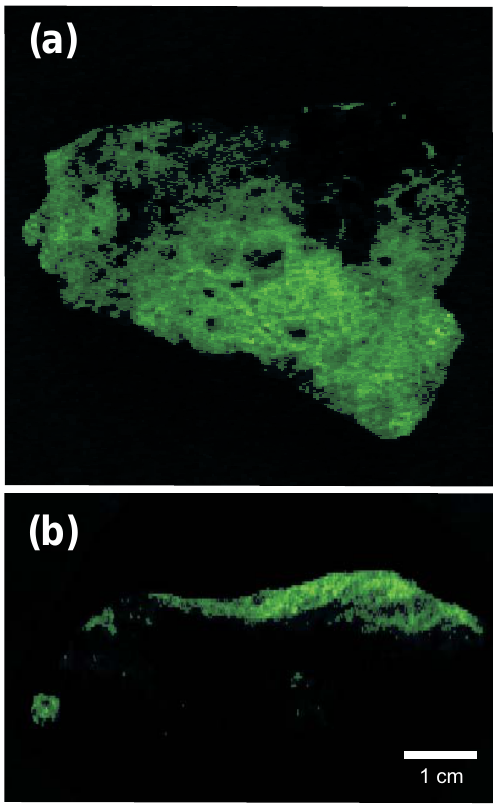
Figure 6. Photoautotrophic mat covering a stone visualised using imaging fluorometry. (a) Upper view, (b) lateral